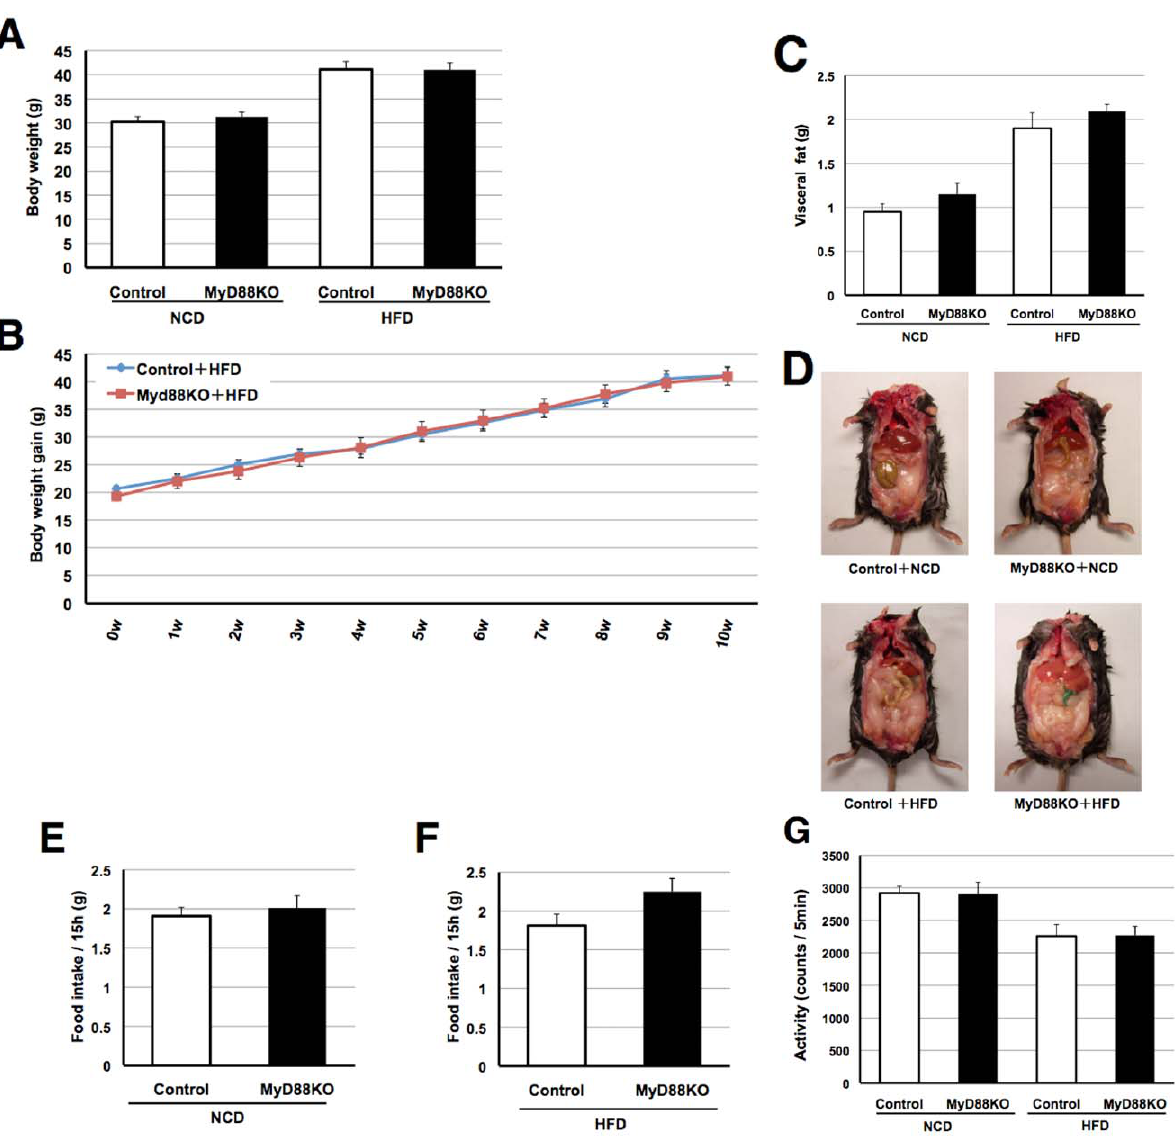
Figure 2. MyD88-deficiency did not affect body weight, adiposity, food intake or locomotor activities. ( A ) Body weight gain was measured in control and MyD88-deficient mice. Both genotypes were fed a NCD until 6 weeks of age and then fed a NCD or HFD for 10 weeks. NCD (n=21–29) and HFD (n=20–26)-fed mice were examined at the age of 16 weeks. ( B ) Control and MyD88-deficient mice were fed the HFD from the age of 6 weeks and body weight gain was measured every week (10 weeks). (n=16–23) ( C ) Visceral fat was measured at the age of 18 weeks. NCD (n=8) HFD (n=6–8) ( D ) Typical photograph of each genotype of mice fed the NCD or HFD. ( EF ) Fifteen hours (From19:00 to 10:00) of food intake was measured in each genotype of mice fed the NCD or HFD at the age of 16 weeks. n=11–13/group ( G ) Locomotor activities (5 min) were measured in each genotype of mice fed the NCD or HFD at the age of 16 weeks. n=11–14/group.